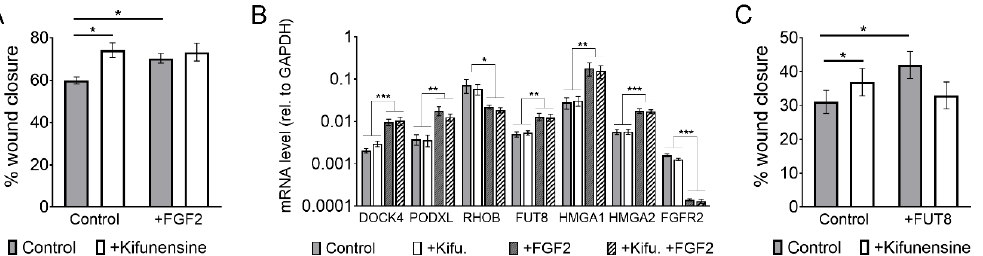
Figure 5. The effect of FGF2 and Kifunensine on migration is not additive. ( A ) Wound/scratch assays showing increased migration with FGF2 and Kifunensine, but no significant increase when both factors are combined ( n = 3). ( B ) RT-PCR to genes regulated by FGF2, but not affected by Kifunensine ( n = 5). ( C ) Wound/scratch assay of MSCs transduced with a control lentivirus or a lentivirus to overexpress FUT8 and treated with or without Kifunensine. Here, Kifunensine and overexpression of FUT8 promote migration, but no additive effect is observed when both conditions are combined ( n = 4). * p < 0.05, ** p < 0.005, *** p < 0.0005.